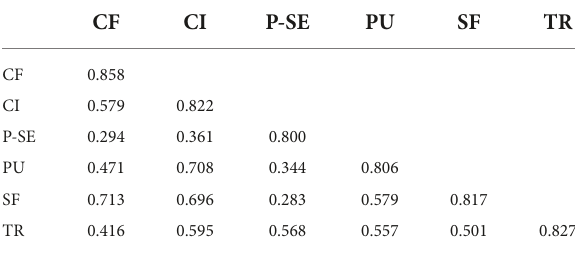
TABLE 2 Results of the measurement model analysis. TABLE 3 Discriminant validity- average variance